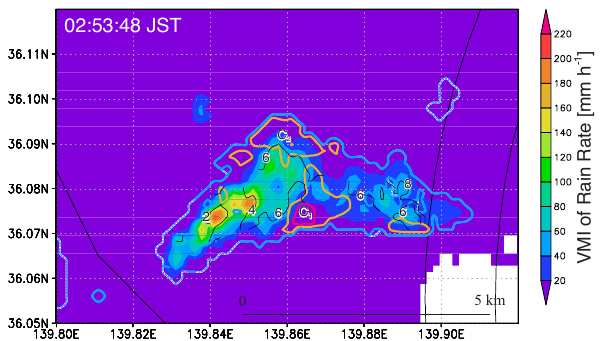
Figure 13. The horizontal distribution of VMI( Z DR ) and the expected arrival time of the maximum rainfall on the ground superimposed over VMI( R ) estimated from the MRI C-band polarimetric radar at 02:57 JST. Solid colored contours indicate VMI( Z DR ) at altitudes above the freezing level from 0 dB with a contour interval of 3 dB. Thin black contours with numbers show the expected arrival time of the maximum intensity rainfall in minutes; thick black contours indicate the estimated surface rainfall rate from 50 mm h -1 with a contour interval of 50 mm h -1 . The arrow indicates the location of the maximum surface rainfall rate, and C 1 -C 3 depict the locations of high Z DR columns.